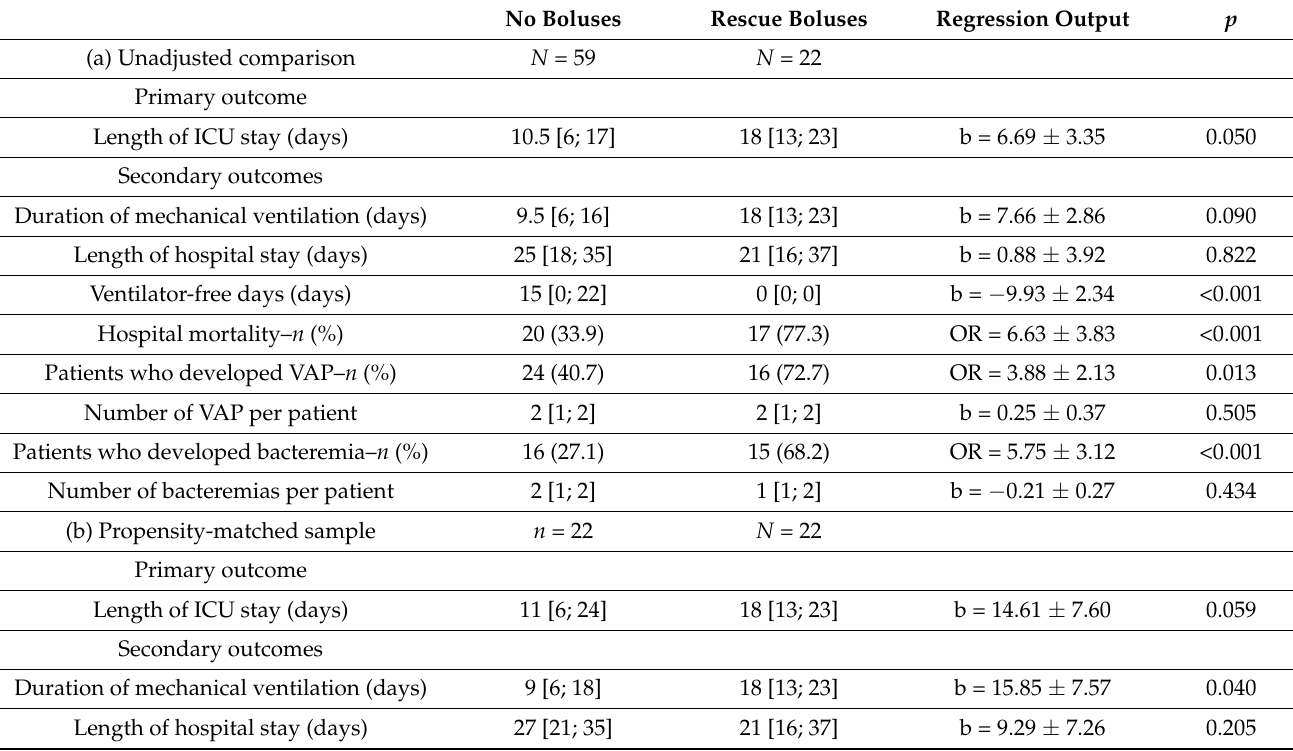
Table 4. Comparison of the outcomes of patients who did and did not receive a rescue course of high-dose